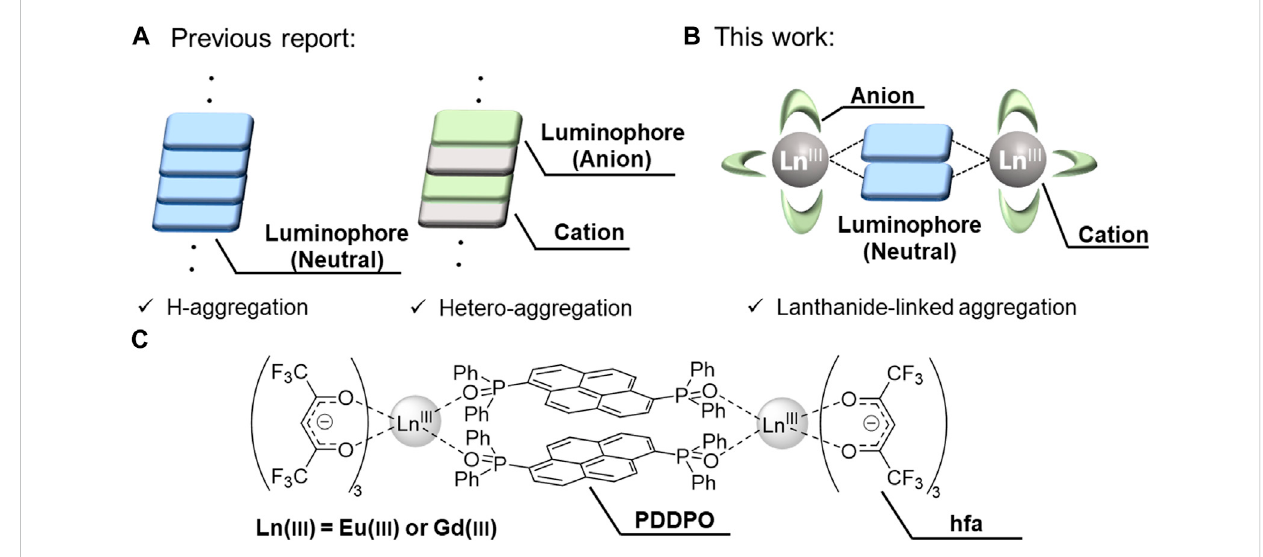
FIGURE 1 (A) Previous strategy: H-aggregation (left) and hetero-aggregation (right). (B) This strategy: Lanthanide-linked aggregation. (C) Chemical structures of lanthanide complexes.